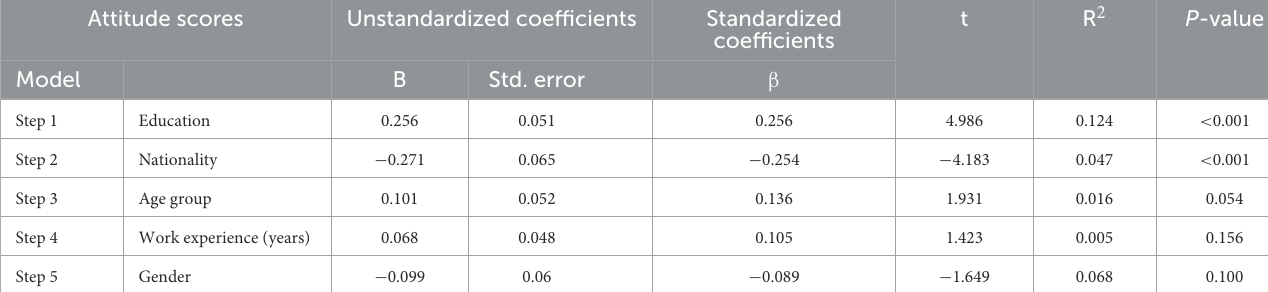
TABLE 4 Identification of factors affecting the attitude of telemedicine by regression